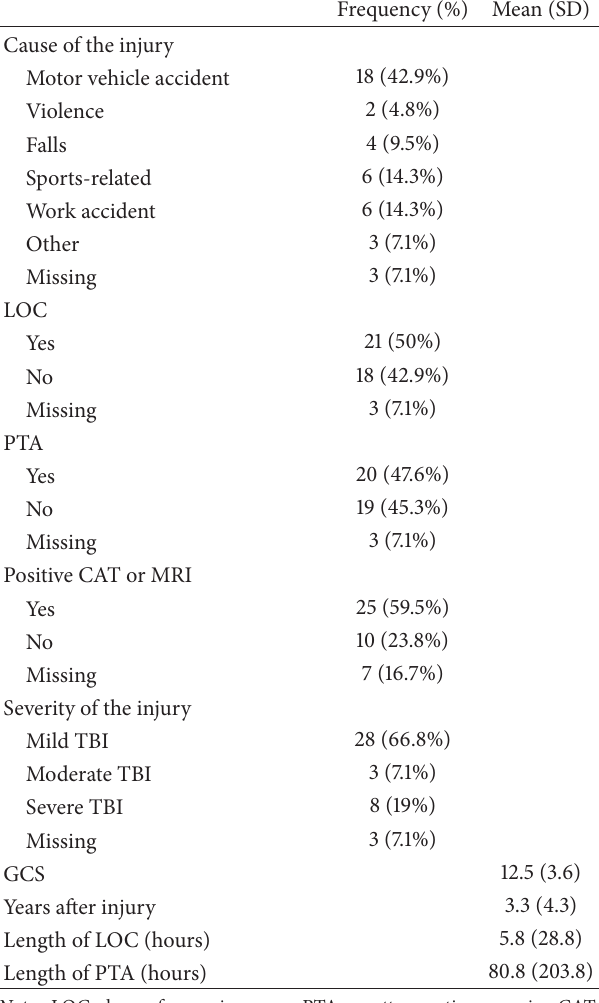
Table 2: Clinical characteristics of the sample of individuals with TBI ( 𝑁 = 42